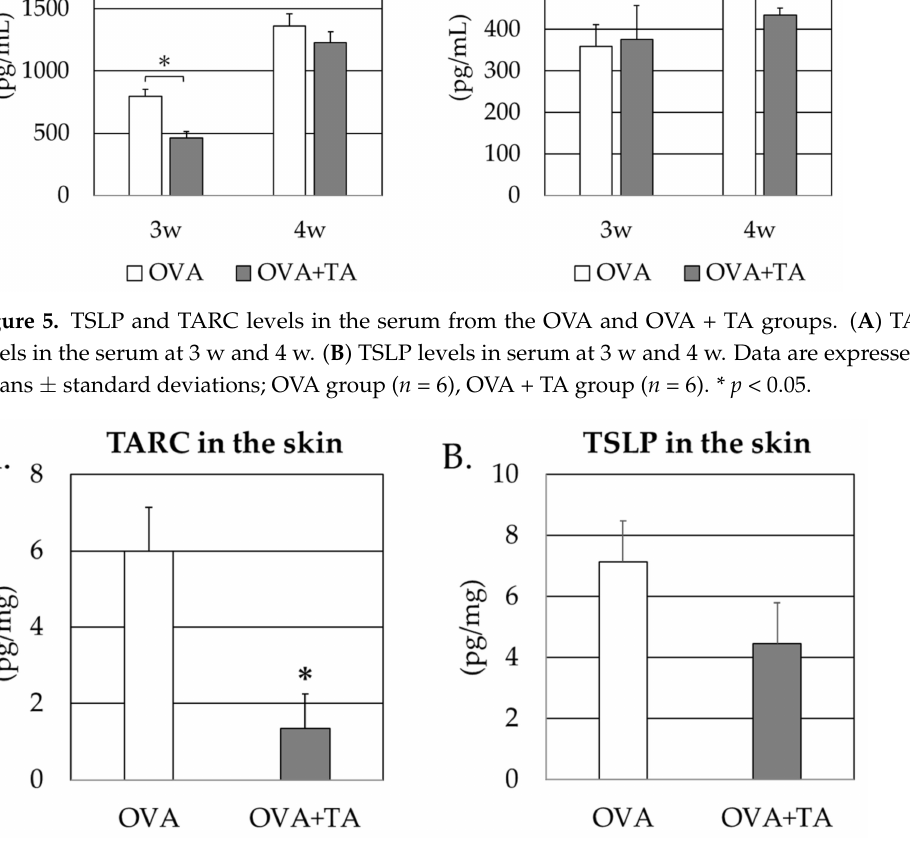
Figure 6. TSLP and TARC levels in the skins from OVA group and OVA + TA group. ( A ) TARC levels in the skin at 4 w. ( B ) TSLP levels in skin at 4 w. Data are expressed as means ± standard deviations; OVA group ( n = 6), OVA + TA group ( n = 6). * p <